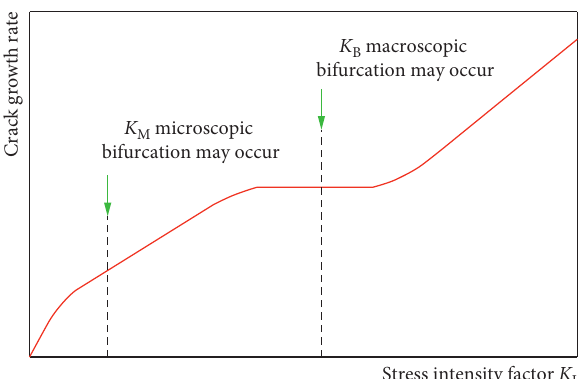
Figure 5: Effects of stress intensity factor on crack